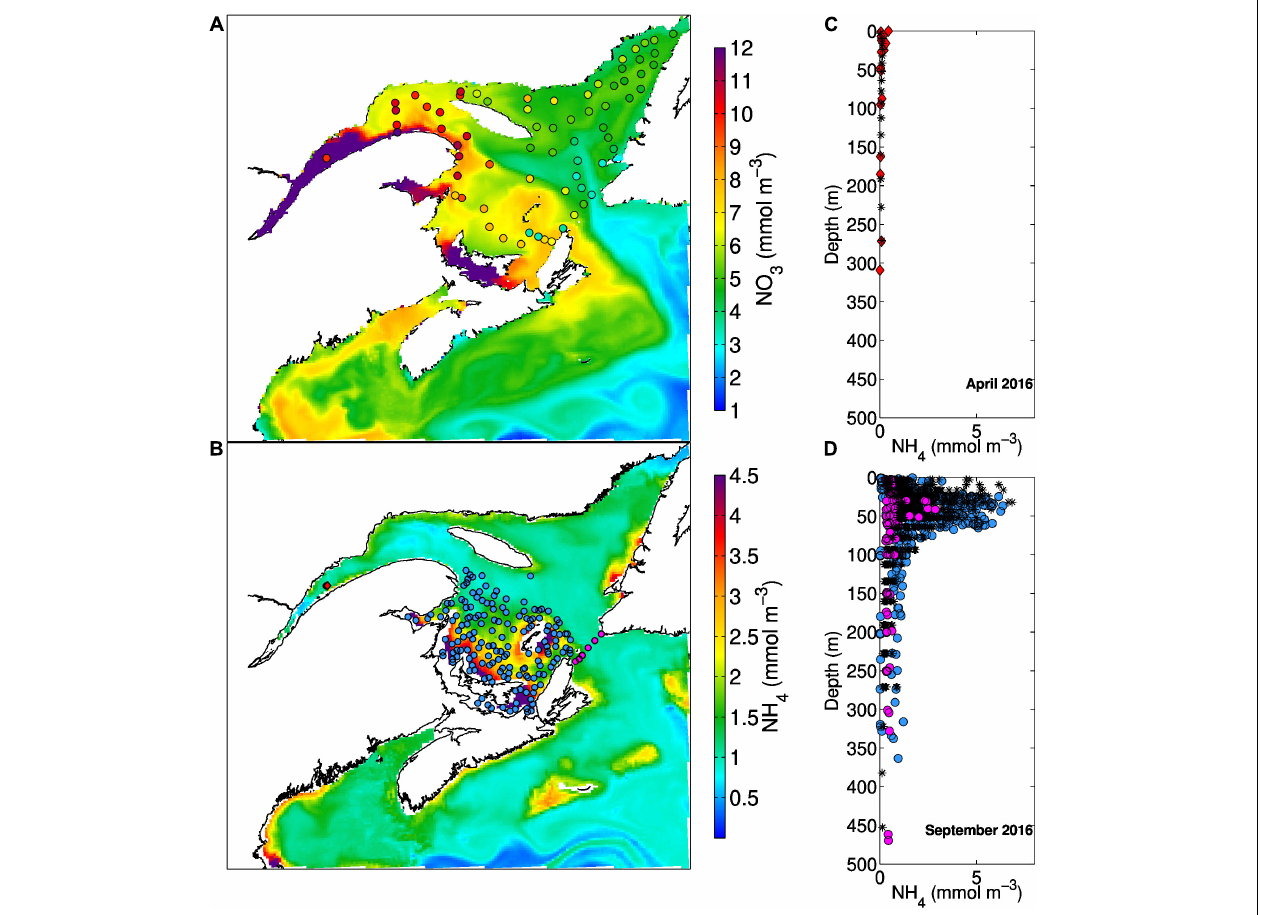
FIGURE 5 | (A) Monthly mean simulated (background) and observed (dots) nitrate concentration in the surface layer (0-6 m for the model and 2 m for the observations) in March 2016. (B) Mean September 2016 ammonium concentration simulated by the model in the 28-58 m layer with position of samples taken in April at the Rimouski station (red diamond) and over the Magdalen Shallows (blue dots) and Cabot Strait (pink dots) in September. The vertical profiles corresponding to these locations are shown to the left (C,D) with the simulated values (corresponding in space and time to the measured profiles) represented by the black